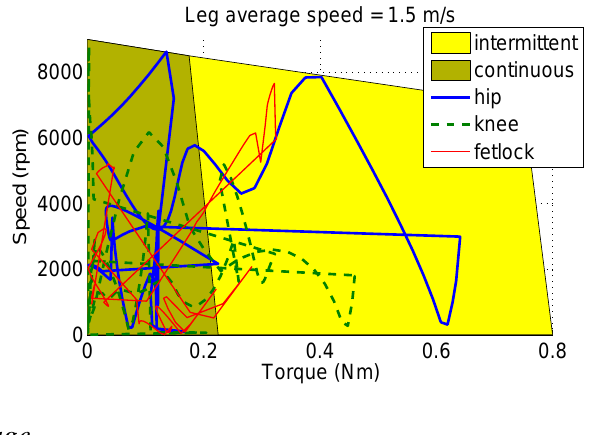
Motor torque-speed diagram overlapped with joint requirements for average nondimensional leg speed of 0.54 considering a biomimetic leg weighing 5